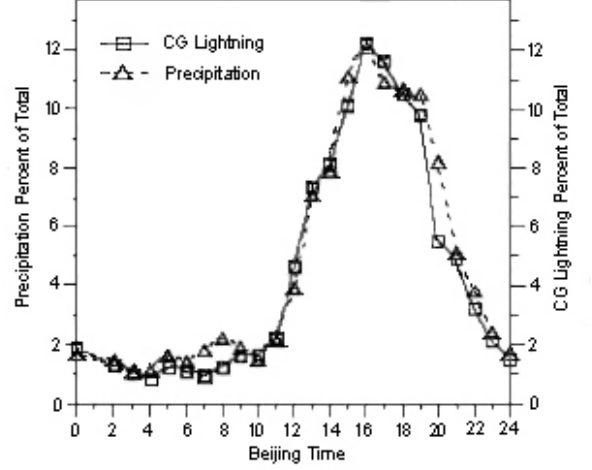
Fig. 3. The variation in the percentage of the total CG lightning and precipitation for all events studied.